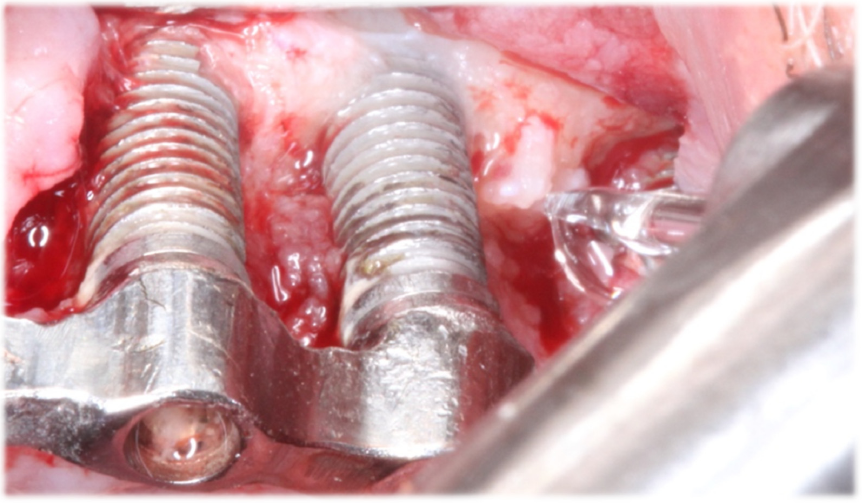
Figure 2. Er: YAG Laser on the Implant Surface.